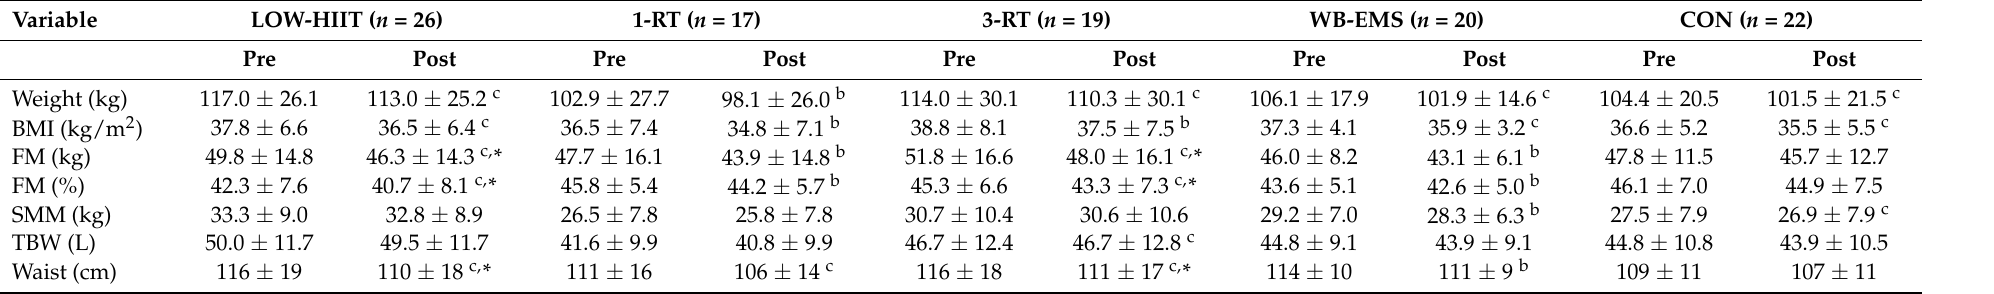
Table 3. Anthropometric and body composition data before and after the